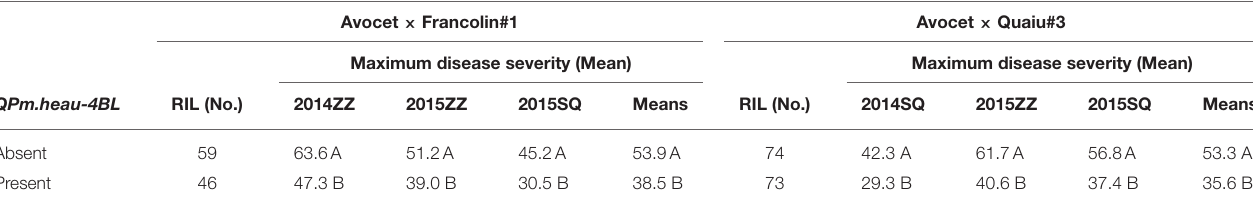
TABLE 4 | t- tests for the comparison of mean maximum disease severity in Avocet × Francolin#1 and Avocet × Quaiu#3 RILs when QPm.heau-4BL was either absent or present.